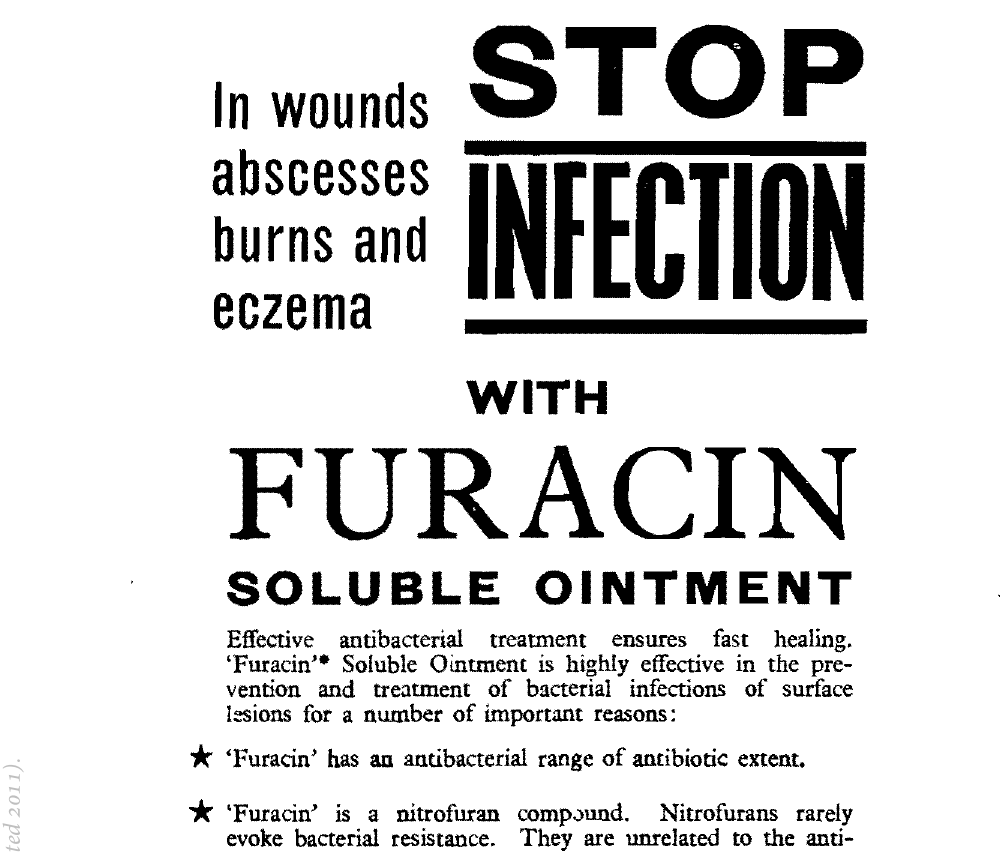
Effective antibacterial